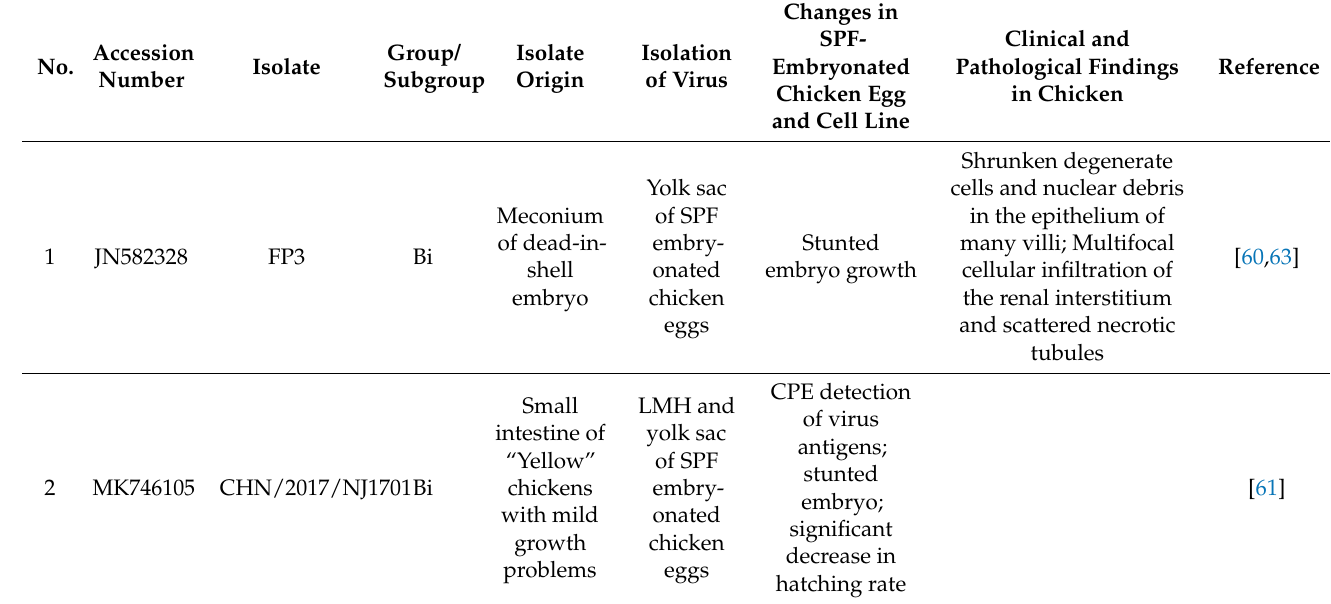
Table 1. In vitro and in vivo pathogenicity study of different subgroups of CAstV